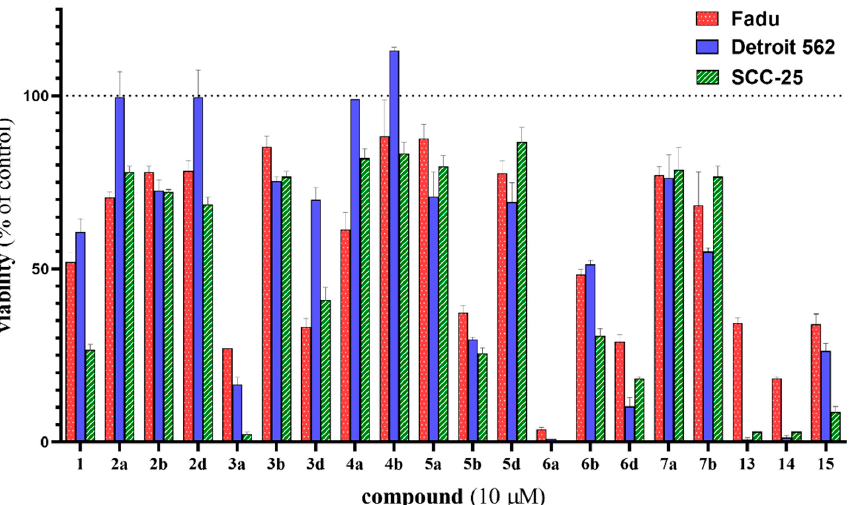
Figure 2. In vitro cell viability inhibition screening of the synthesized hybrid compounds on Fadu, Detroit 562 and SCC-25 NHSCC cell lines using CellTiter-Glo cell viability assay. Cells were